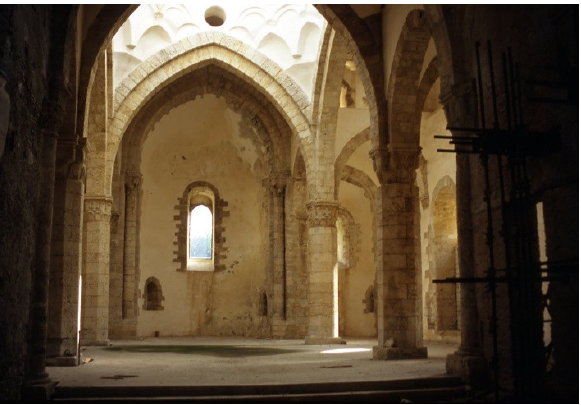
Figure 3. Church of Santa Maria della Valle (called Badiazza), central apse. Image courtesy